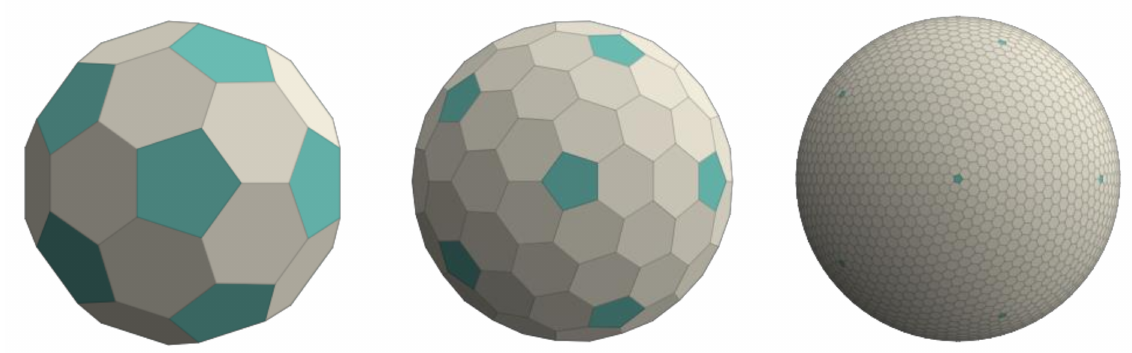
Figure 1. Three different Goldberg